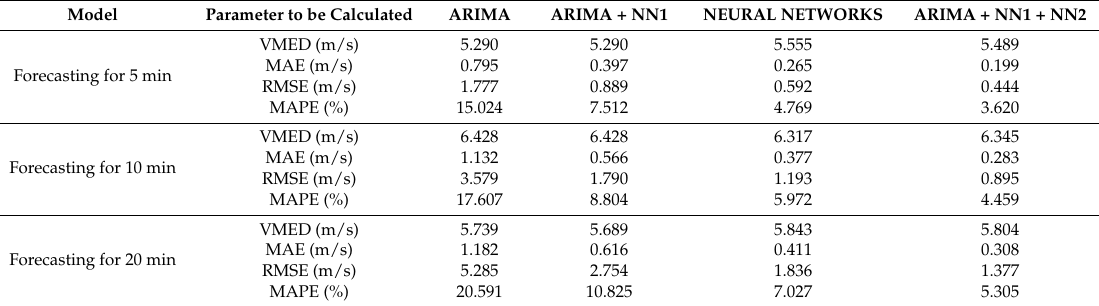
Table 3. Results of errors of predicted speed for multi-step forecast ultra-short term (minutes). Model Parameter to be Calculated ARIMA ARIMA + NN1 ARIMA + NN1 + NN2 Forecasting for 5 min